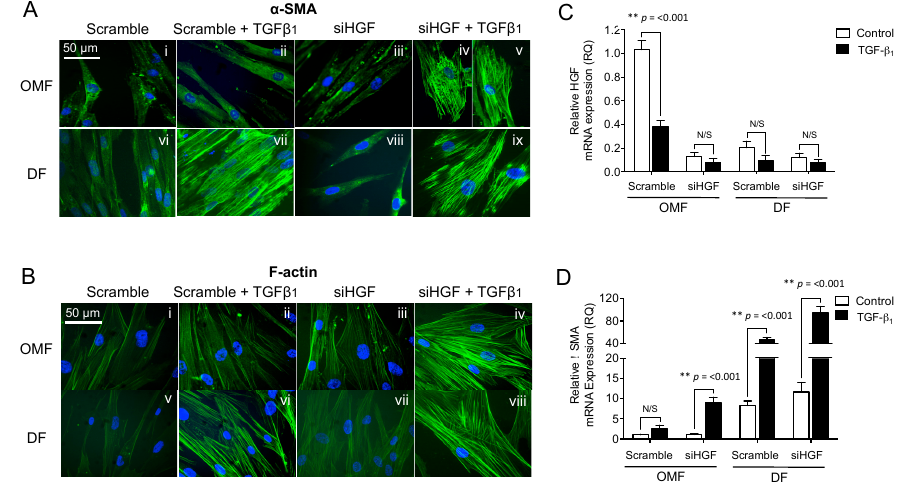
Figure 4. Knockdown of HGF, followed by TGF- β 1 supplementation, is sufficient to differentiate OMFs into myofibroblasts. siHGF- and scrambled siRNA-transfected OMFs and DFs were growth-arrested and maintained in serum-free F-SCM or serum-free F-SCM containing TGF- β 1 (10 ng/mL), for 72 h. The effects of exogenous TGF- β 1 supplementation on ( A ) α -SMA staining and ( B ) F-actin cytoskeletal reorganisation/cellular morphology were assessed. α -SMA and F-actin images are representative of one independent experiment of three (scale bar = 50 µ m, original magnification 400 × ). siHGF- and scrambled siRNA-transfected OMFs, and patient-matched DFs, were further assessed for ( C ) HGF and ( D ) α -SMA mRNA expression. Images are representative of n = 3 independent experiments. Graphical data is shown as mean ± S.E. for n = 6 independent experiments (* p ≤ 0.05, ** p ≤ 0.01; N/S, no significance).